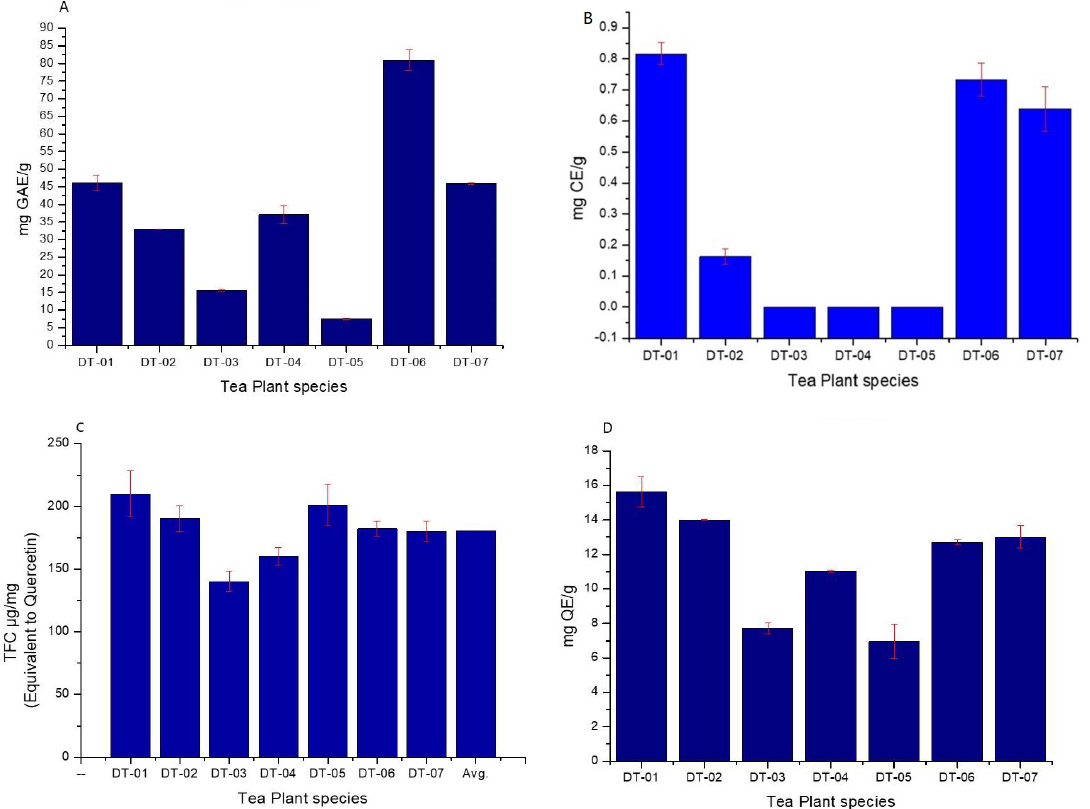
Figure 3. Evaluation of antioxidant compounds in all the tea plants. ( A ) Estimation of polyphenols equivalent to gallic acid; ( B ) estimation of flavanols equivalent to catechin; ( C ) total flavonoid content (TFC) estimation; ( D ) estimation of flavonols equivalent to